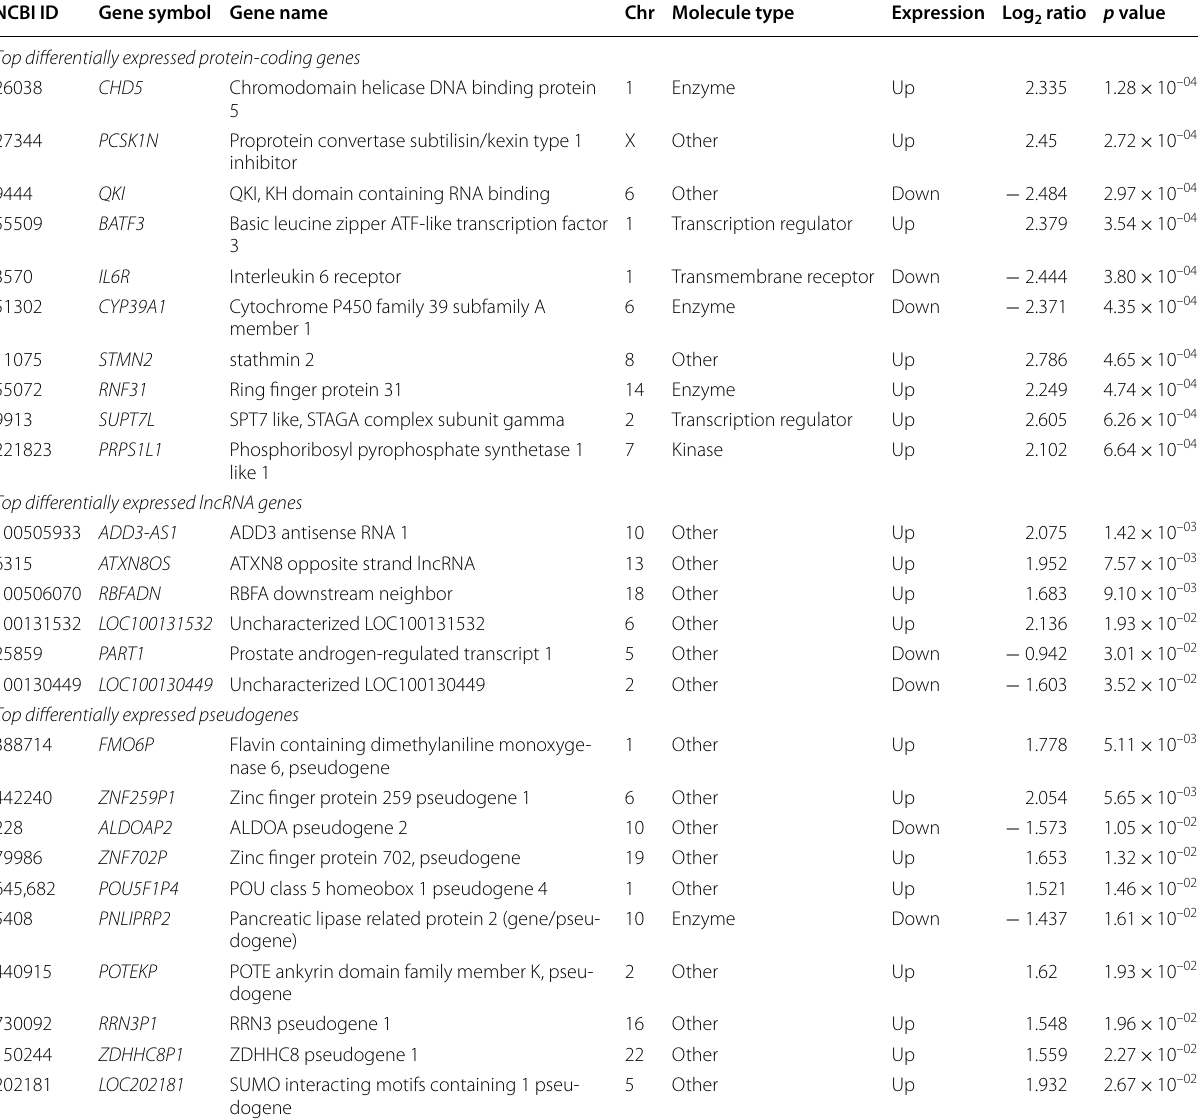
Table 2 Significantly differentially expressed genes in smokers as revealed by IPA and as sorted by p value